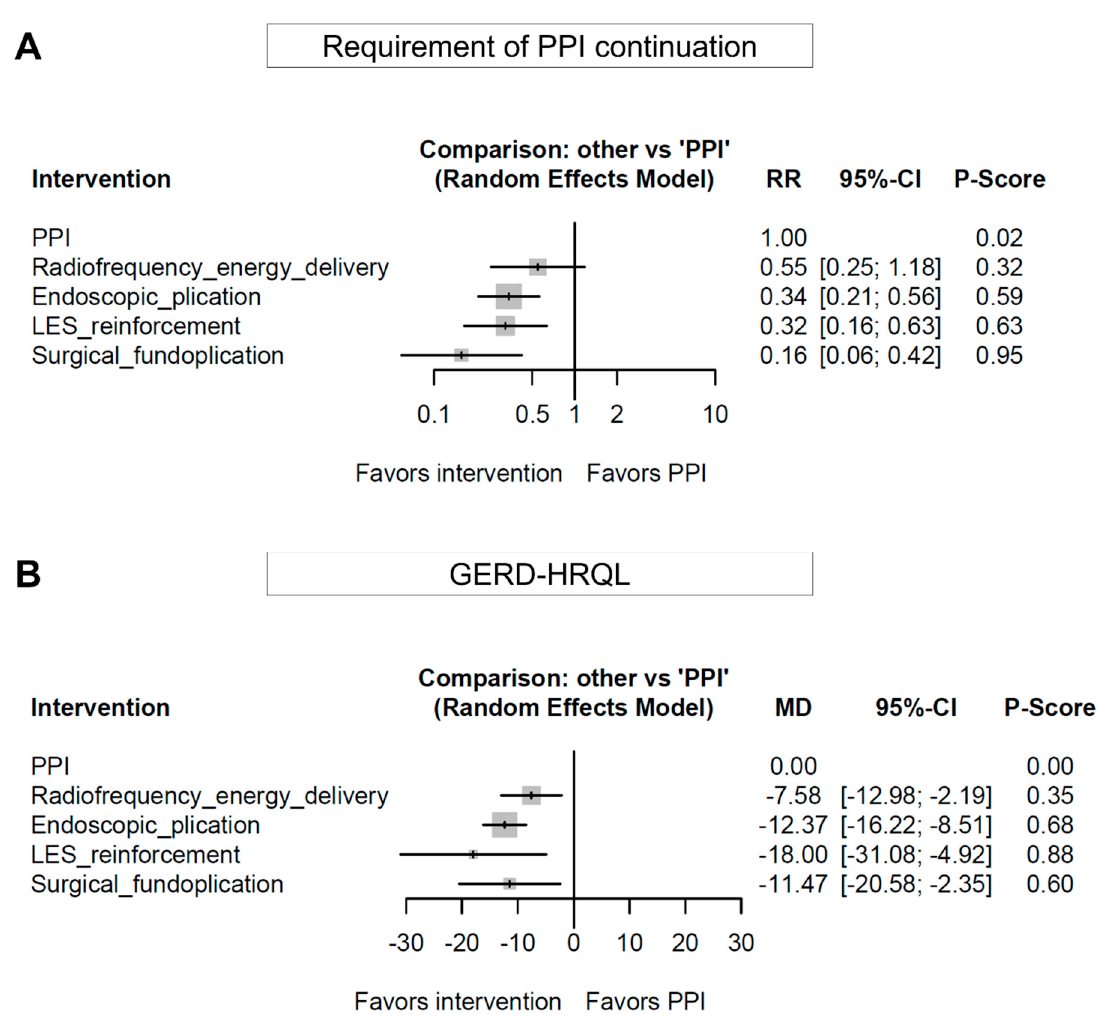
Figure 4. Comparative efficacy for the requirement of PPI continuation ( A ) and GERD-HRQL score ( B ) in the network meta-analysis. The P-score indicates the mean extent of certainty that one treatment is better than another. PPI, proton pump inhibitor; GERD, gastroesophageal reflux disease; HRQL, health-related quality of life questionnaire; LES, lower esophageal sphincter; RR, risk ratio; MD, mean difference; CI, confidence interval.